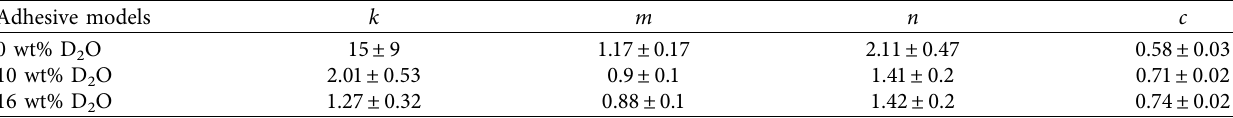
Figure 2: Polymerization kinetics of adhesive models with different amounts of D Table 2: Kinetic constants referring to the autocatalytic model adjusted to the experimental results presented in Figure 2. Adhesive